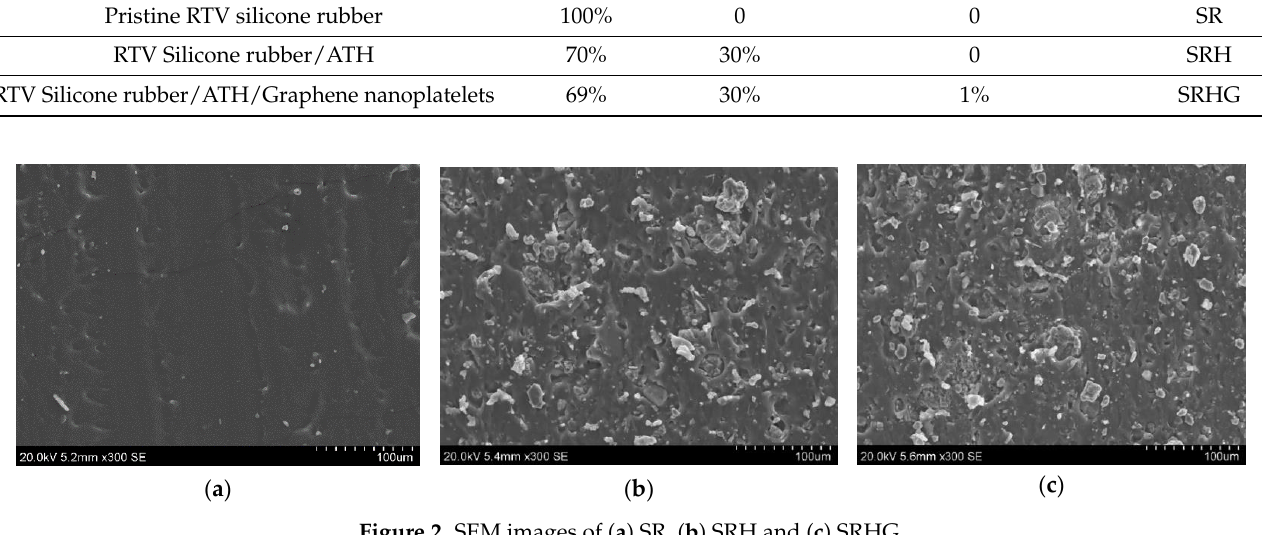
Figure 2. SEM images of ( a ) SR, ( b ) SRH and ( c )